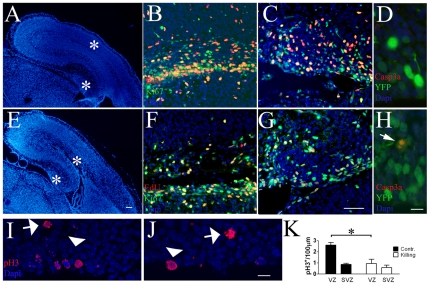
The selective killing of E12.7 AspM+ cells impairs neurogenesis.AspM-CreERT2/Nestin-GFPflox-TK double transgenic mice (n = 4, E–G) and their control litters –i.e. mice lacking the Nestin-GFPflox-TK transgene- (n = 4, A–C) were injected with Tam at E12.7 and E13.2, then daily administered with GCV and treated with EdU one hour before the sacrifice at E18.5. Coronal sections of double transgenic mice show a substantial derangement of brain architecture as shown in panels A and E. AspM-CreERT2/Nestin-GFPflox-TK brains were stained for EdU and Ki67 detection. Double transgenic mice administered with Tam/GCV show a significant reduction of proliferating cells within the cortical VZ/SVZ (F) and in the dentate gyrus (G), when compared with their controls (B, C). Sections from controls (I) and double transgenic mice (J) were stained for pH3 detection, and the mean number of cells/100 µm (± S.D.) is plotted on panel K. AspM-CreERT2/Nestin-GFPflox-TK/Rosa26YFP transgenic mice and their control litters (AspM-CreERT/Rosa26YFP mice) were administered with Tam and GCV (n = 4 for each group). Brains were collected at E16.5 and probed for YFP and Casp3a. Double positive cells are detected in triple transgenic mice (arrow in H indicates a double positive cells in the VZ of triple transgenic mice), but not in their controls (D). * p<0.05, t-student. Scale bar 100 µm and 10 µm in panels G and H, respectively.